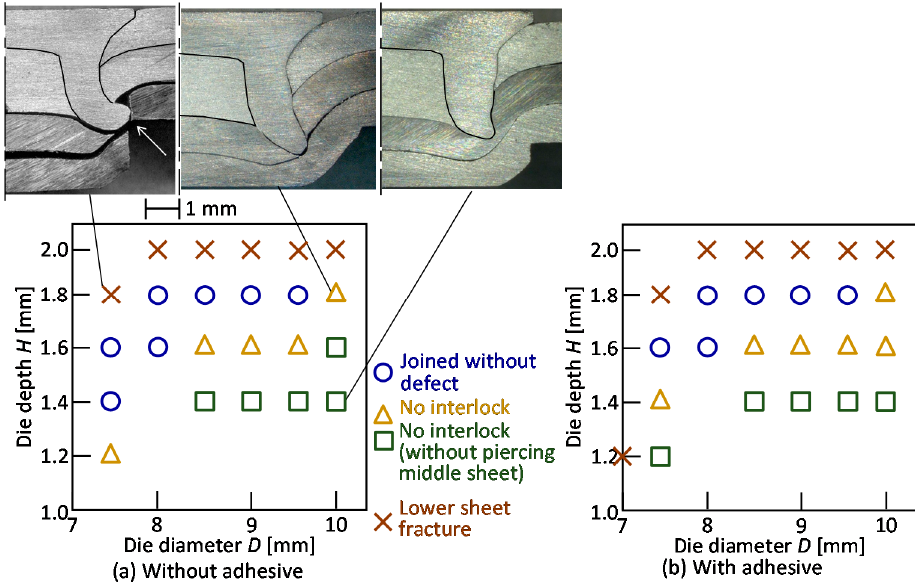
Figure 8. Joining ranges for L = 5 mm: ( a ) without adhesive; ( b ) with adhesive.